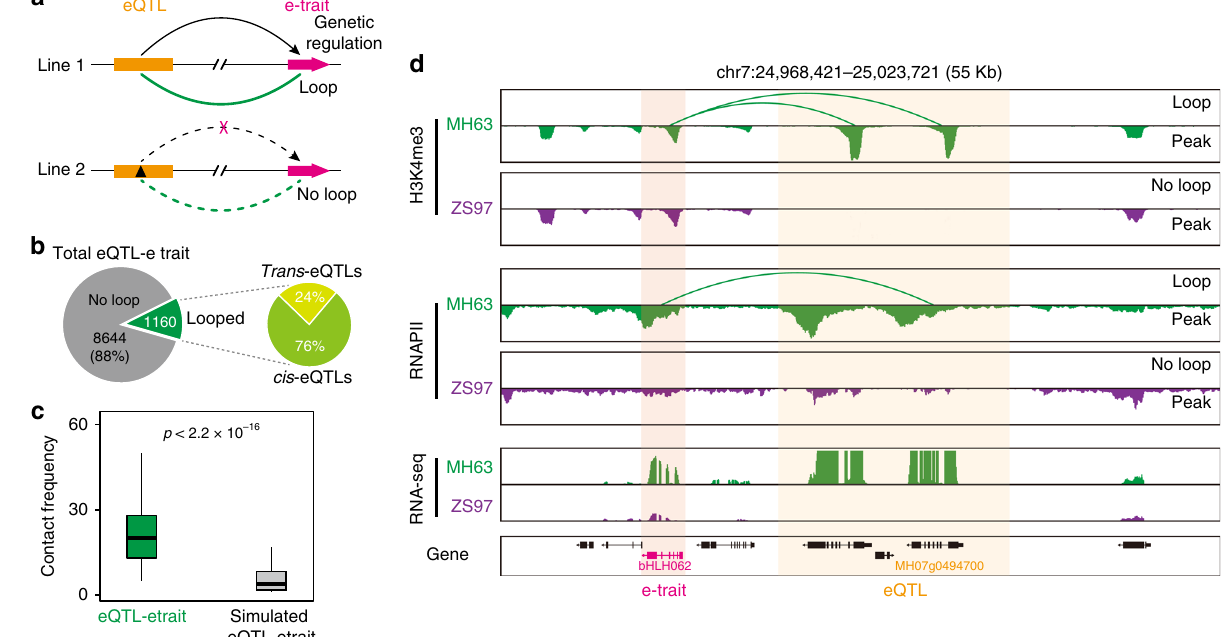
Fig. 6 Spatial correlation for the genetic regulation of eQTLs to e-traits. a Schematic of expression quantitative trait locus (eQTLs) and expression traits (e-traits) linkages established by ChIA-PET loops. b Percentage and numbers of ChIA-PET loop-supported genetic regulation of eQTLs to e-traits (left) and the percentage of trans -eQTLs and cis -eQTLs (right). c Contact frequency of ChIA-PET loop-supported and simulated eQTL-etrait pairs. The distance distribution of simulated eQTL-etrait pairs is similar to that of real eQTL-etrait pairs. The p value was calculated by Wilcoxon test. Boxplots show the median, and third and fi rst quartiles. d A representative example of ChIA-PET loop-supported eQTLs and e-trait genetic regulation. In MH63, a gene bHLH062 is regulated by an eQTL segment, and they are contacted by H3K4me3- and RNAPII-mediated interactions, while in ZS97, this correlation does not exist. The left highlighted bar shows that this gene exhibits different transcription patterns in rice (MH63 vs ZS97). Source data of c are provided as